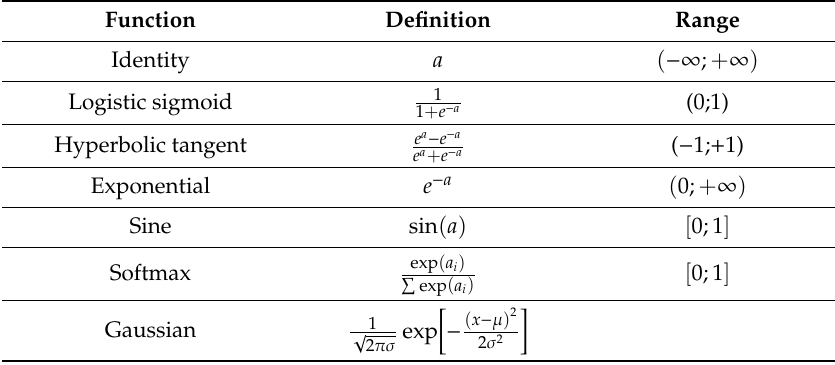
Table 2. Activation functions of MLP and RBF hidden and output layer.